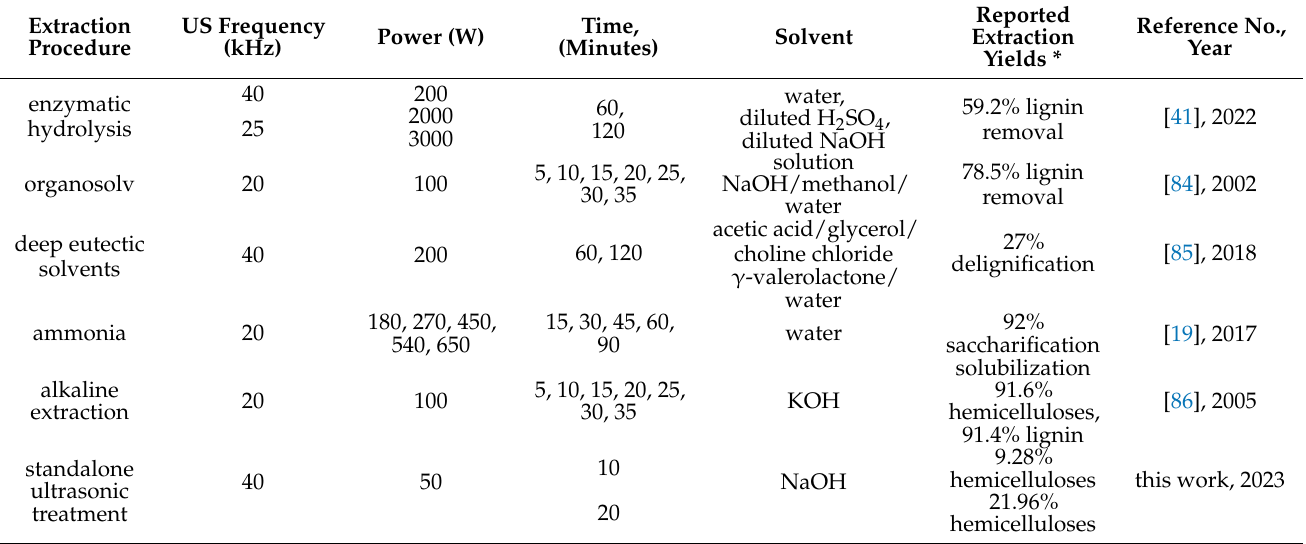
Table 9. Comparison of US-assisted wheat straw